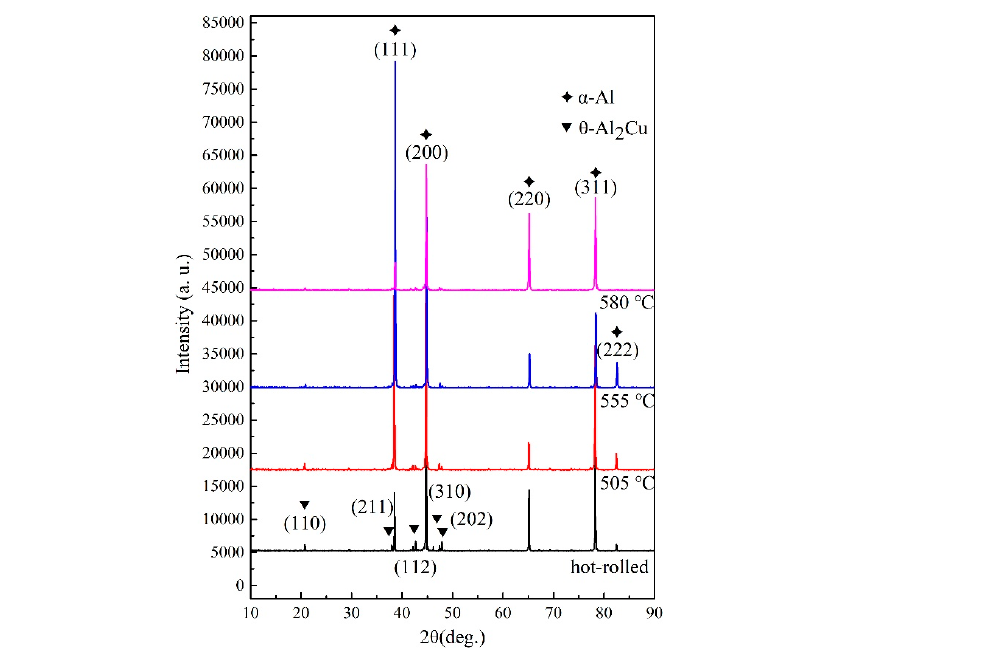
Figure 10. XRD result of the 2A14 aluminum alloy at the hot-rolled state after annealing to 505 °C, 555 °C, and 580 °C.